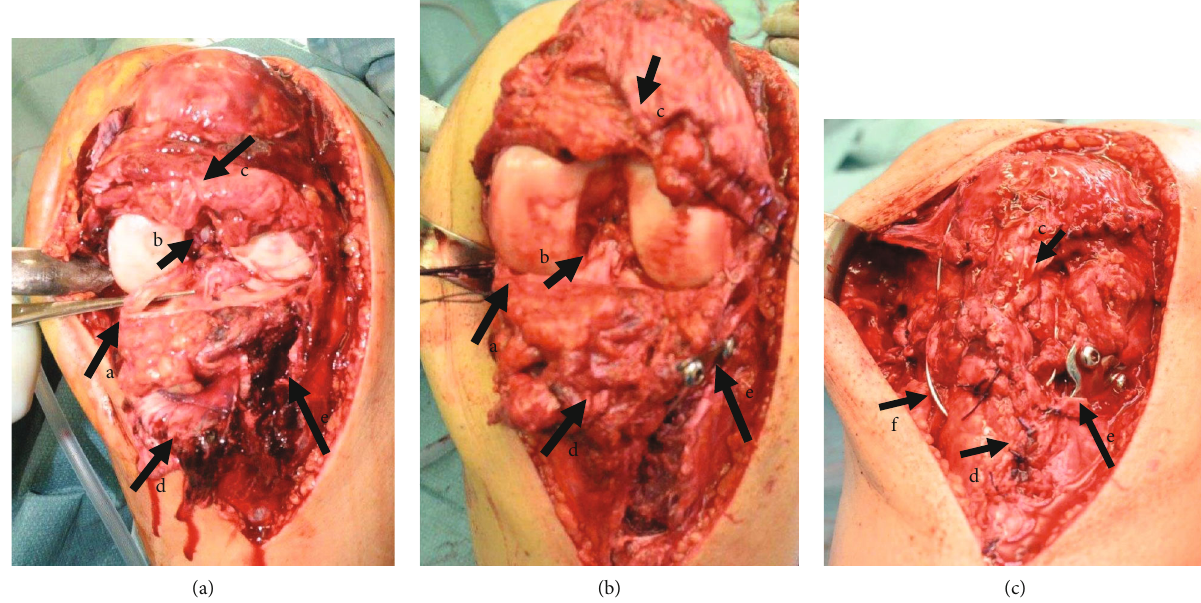
Figure 2: Intraoperative photos after the exposure of the joint (a); after the ORIF of the tibia, ACL reconstruction, and meniscus suturing (b); and after the PT repair (c). Note on the fi gures: (A) bucket handle tear of the medial meniscus before and after suturing, (B) absence of the ACL in the notch, the tibial stump of the ACL, and the reconstructed ACL, (C) the proximal and (D) distal stump of the PT before and after reconstruction, (E) the tibial plateau fracture before and after ORIF, and (F) the McLaughlin wire.